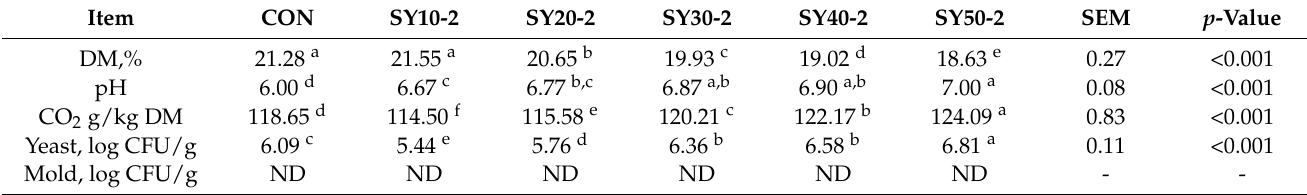
Table 5. Aerobic stability test results of corn silages.